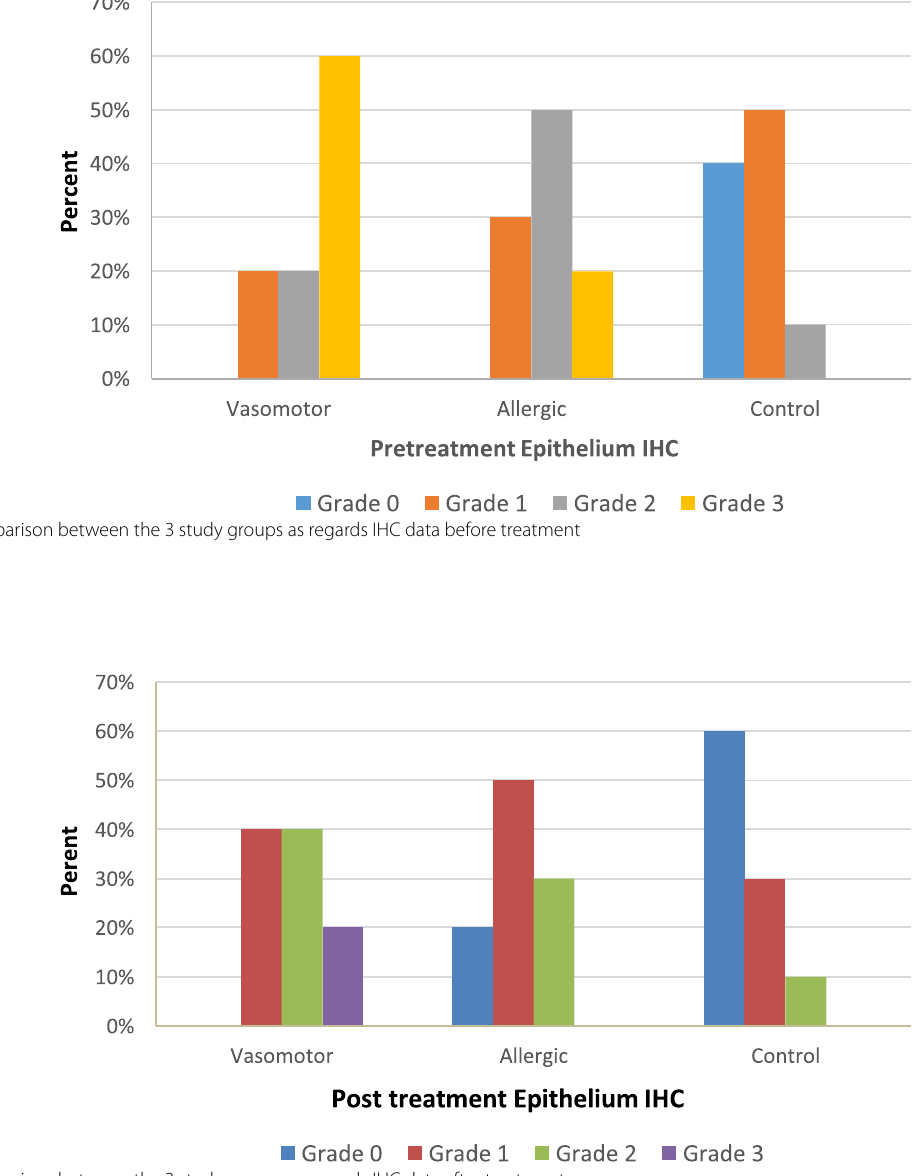
Fig. 7 Comparison between the 3 study groups as regards IHC data after